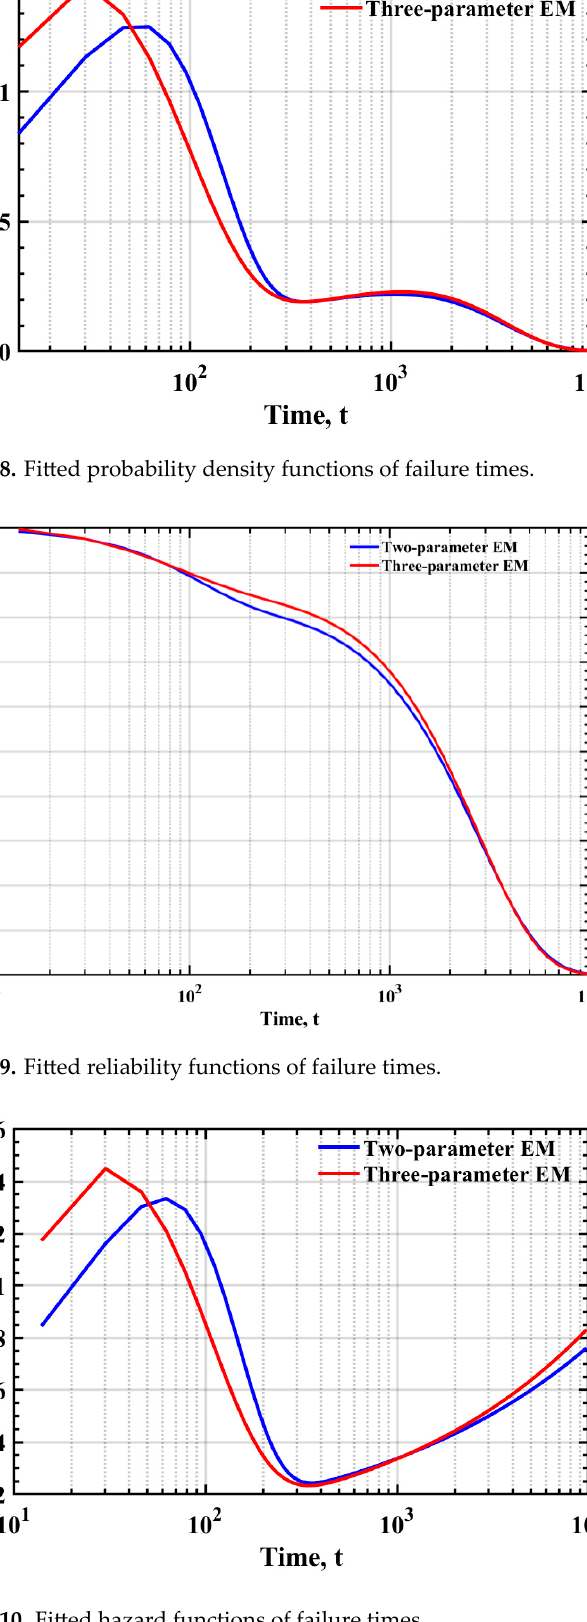
Figure 10. Fitted hazard functions of failure times.